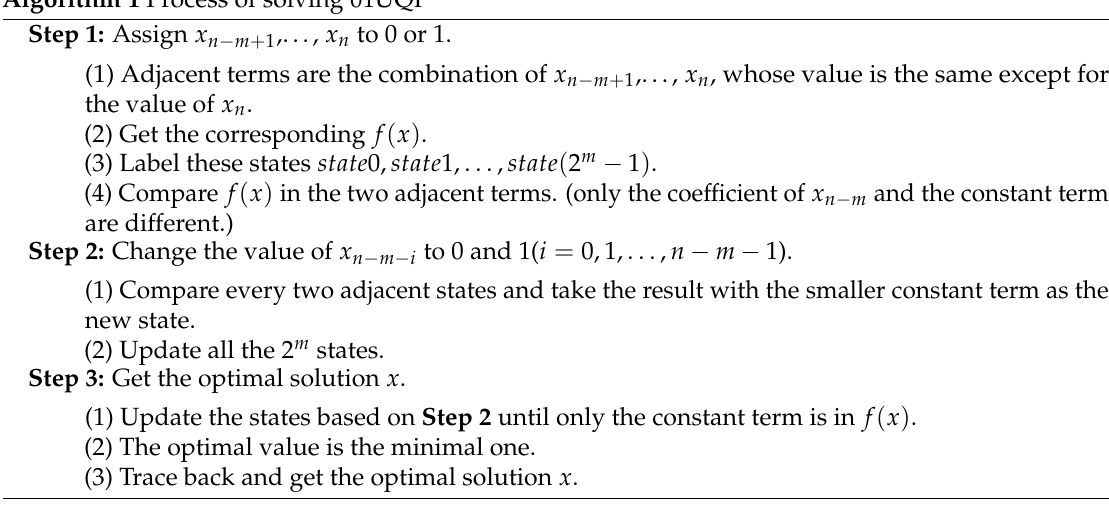
Figure 1. Flow chart of the zero-one unconstrained quadratic programming (01UQP) algorithm. Algorithm 1 Process of solving